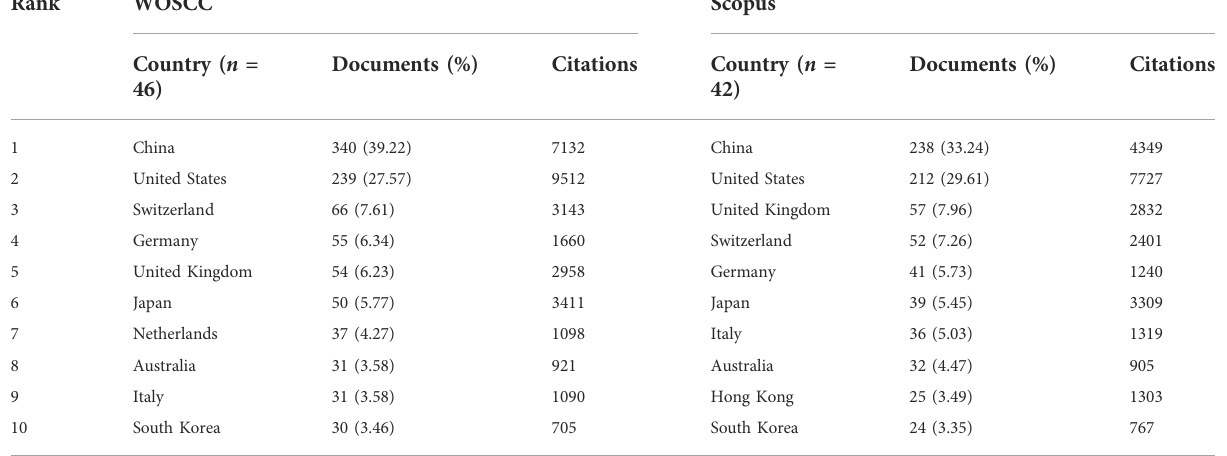
TABLE 1 Top 10 Countrys contributing to Publications in the WOSCC and Scoups database. Rank Scopus Documents (%)